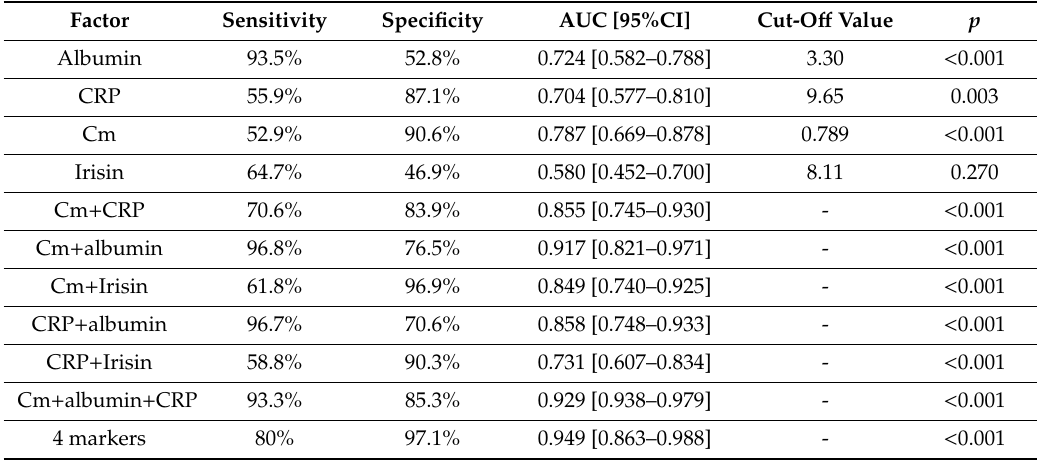
Table 5. Tests accuracy of CRP, irisin, albumin, Cm and their combination to distinguish cachectic CHF patients from non-cachectic CHF